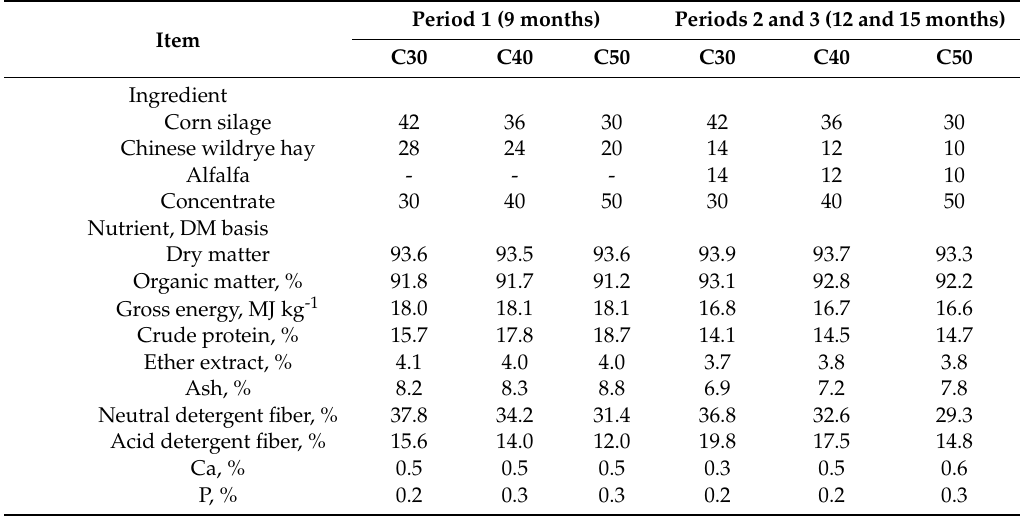
Table 1. Ingredient and chemical composition of diets in the current